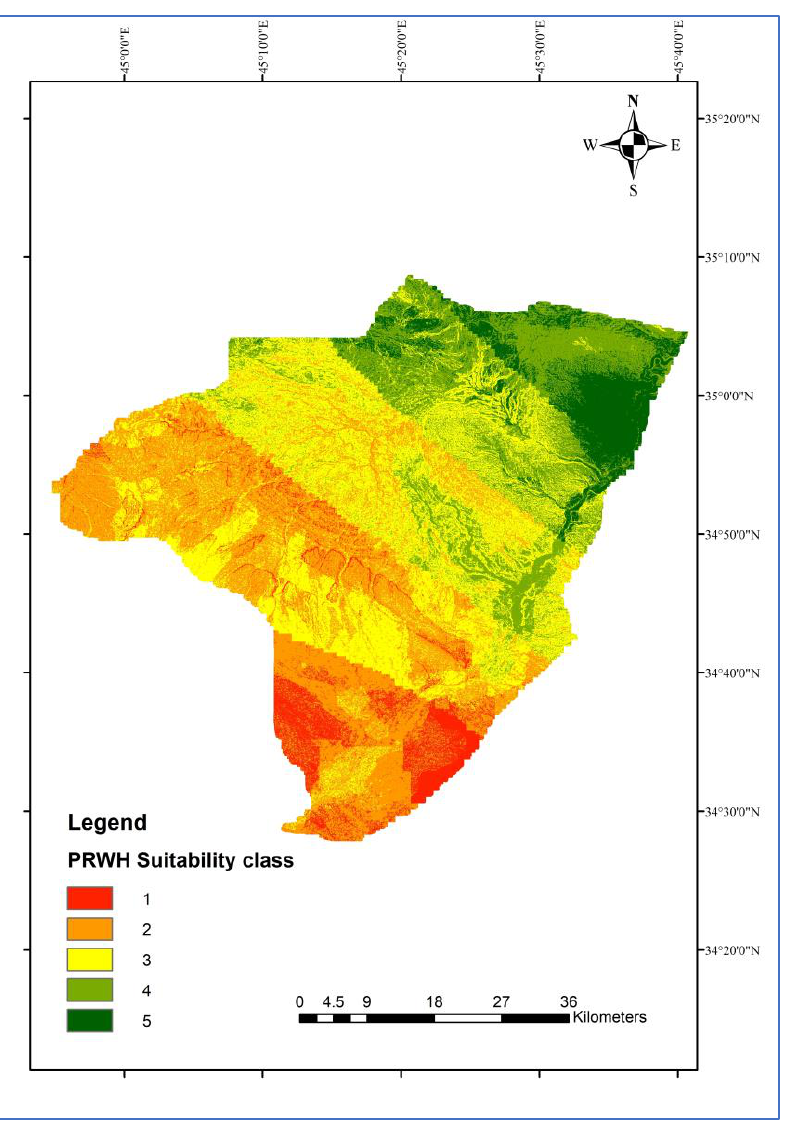
Figure 12. Potential RWH map.